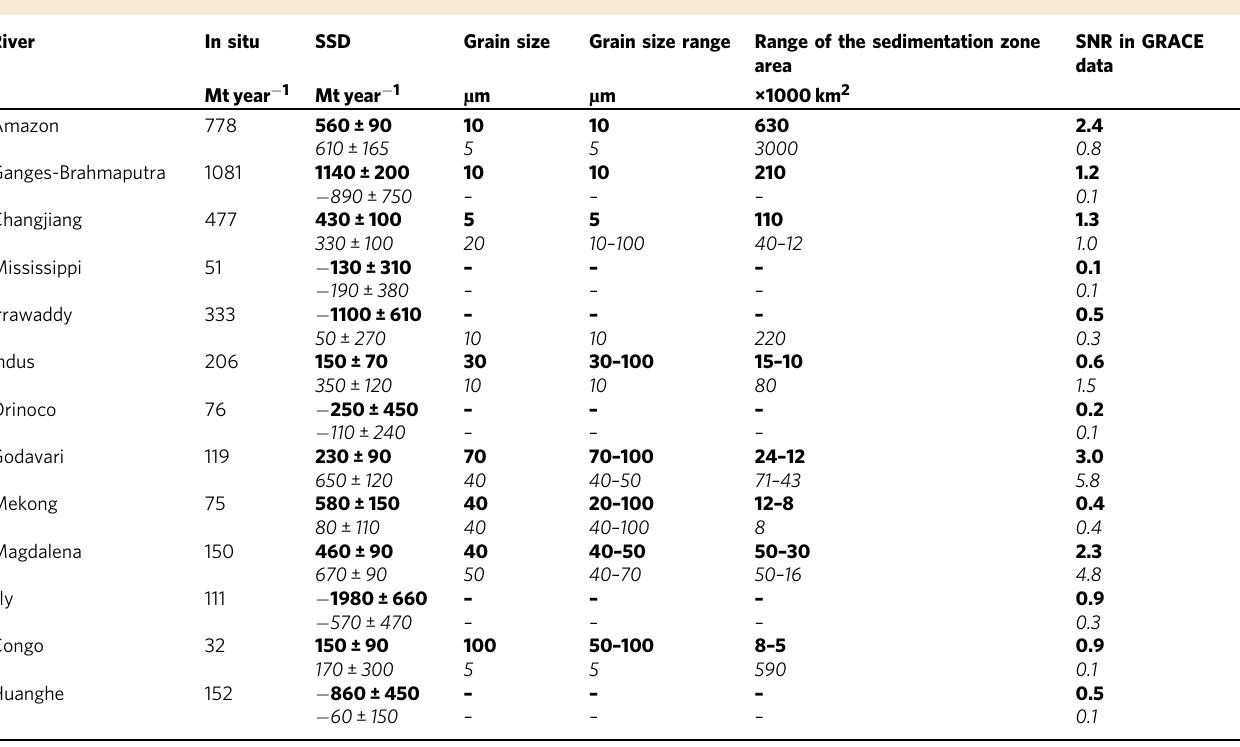
Table 1 Satellite-derived sediment discharge (SSD)